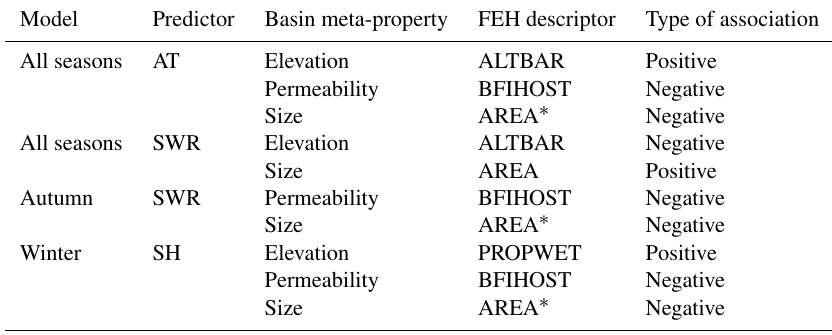
Table 4. Basin descriptors significantly related to site-specific model coefficients (ANOVA; p ≤ 0 . 05). Model Predictor